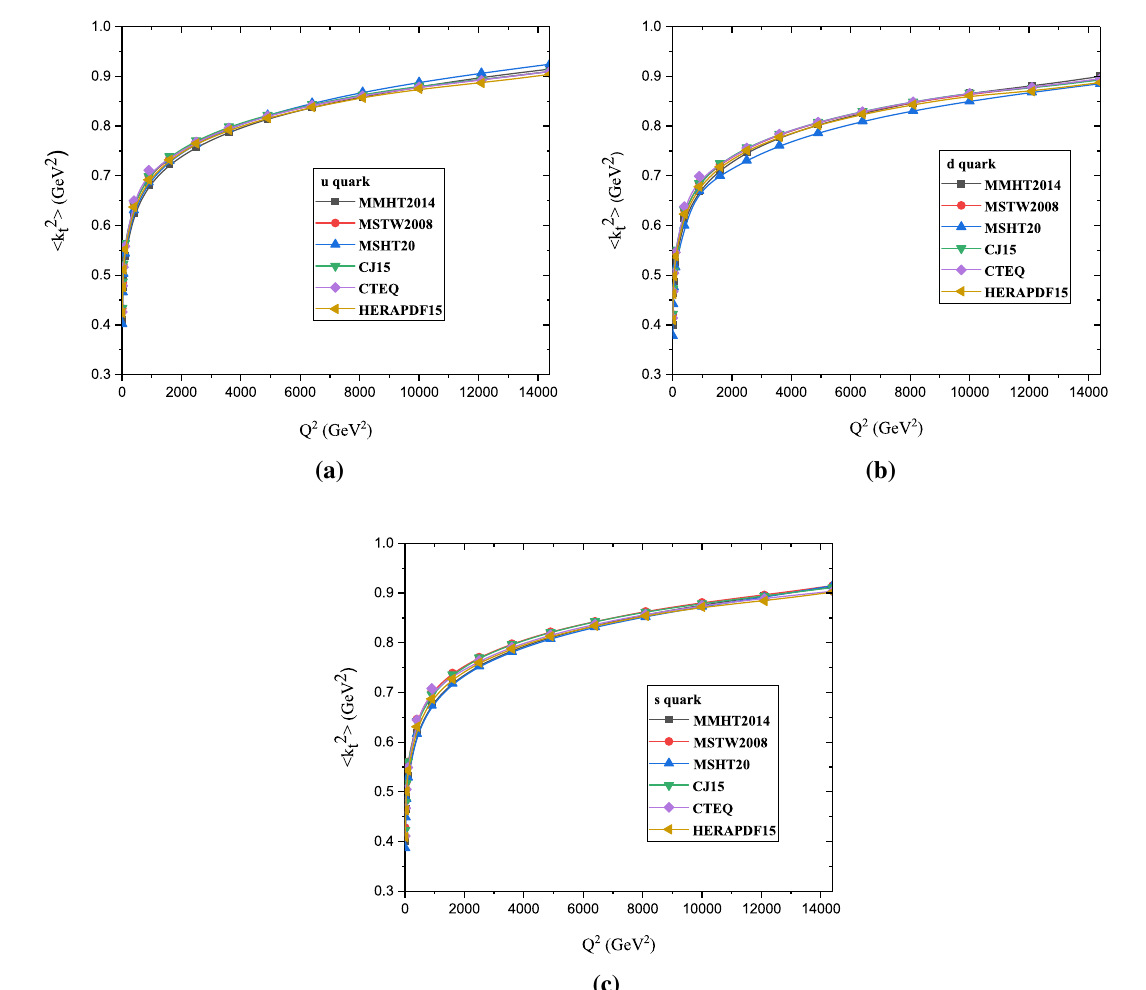
Fig. 6 The plots of (cid:2) k 2 t (cid:3) for the light quarks, using different PDFs sets: a u quark, b d quark, c s quark